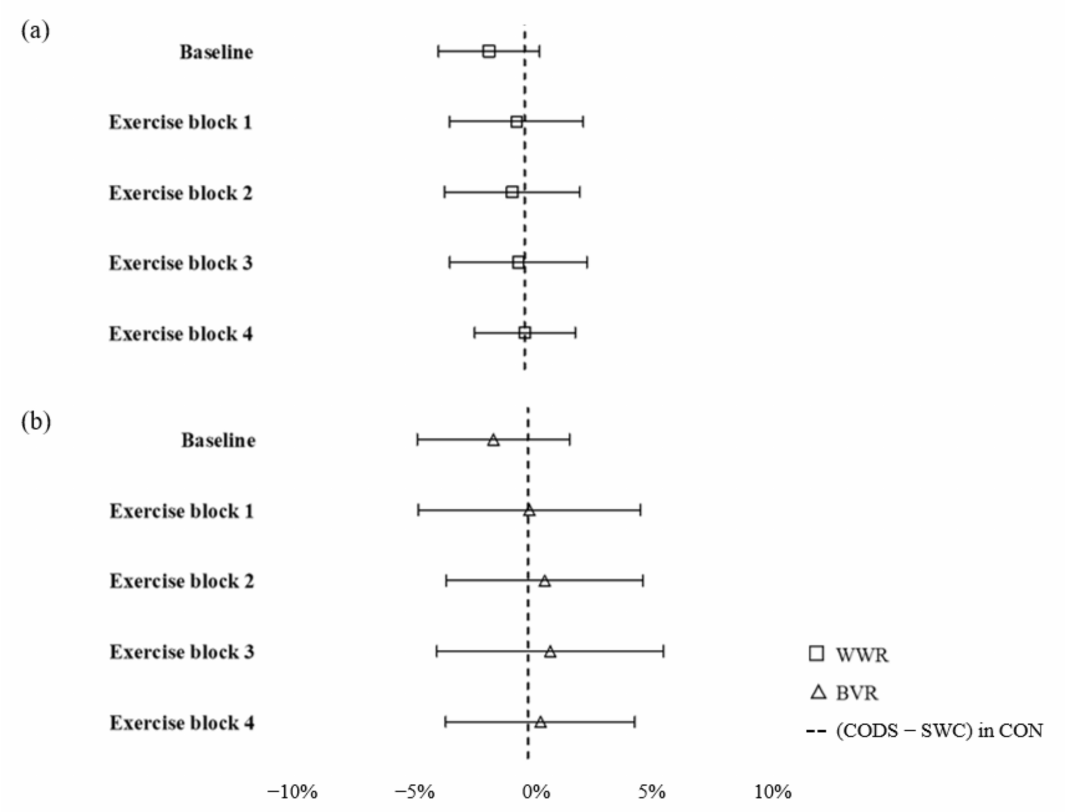
Figure 5. Percentage difference (%DIFF) of change of direction speed (CODS) in WWR ( a ) and BVR ( b ) vs. CODS–SWC in CON at each measured timepoint. SWC observed at baseline, exercise block 1 to exercise block 3 in ( a ) and baseline in ( b